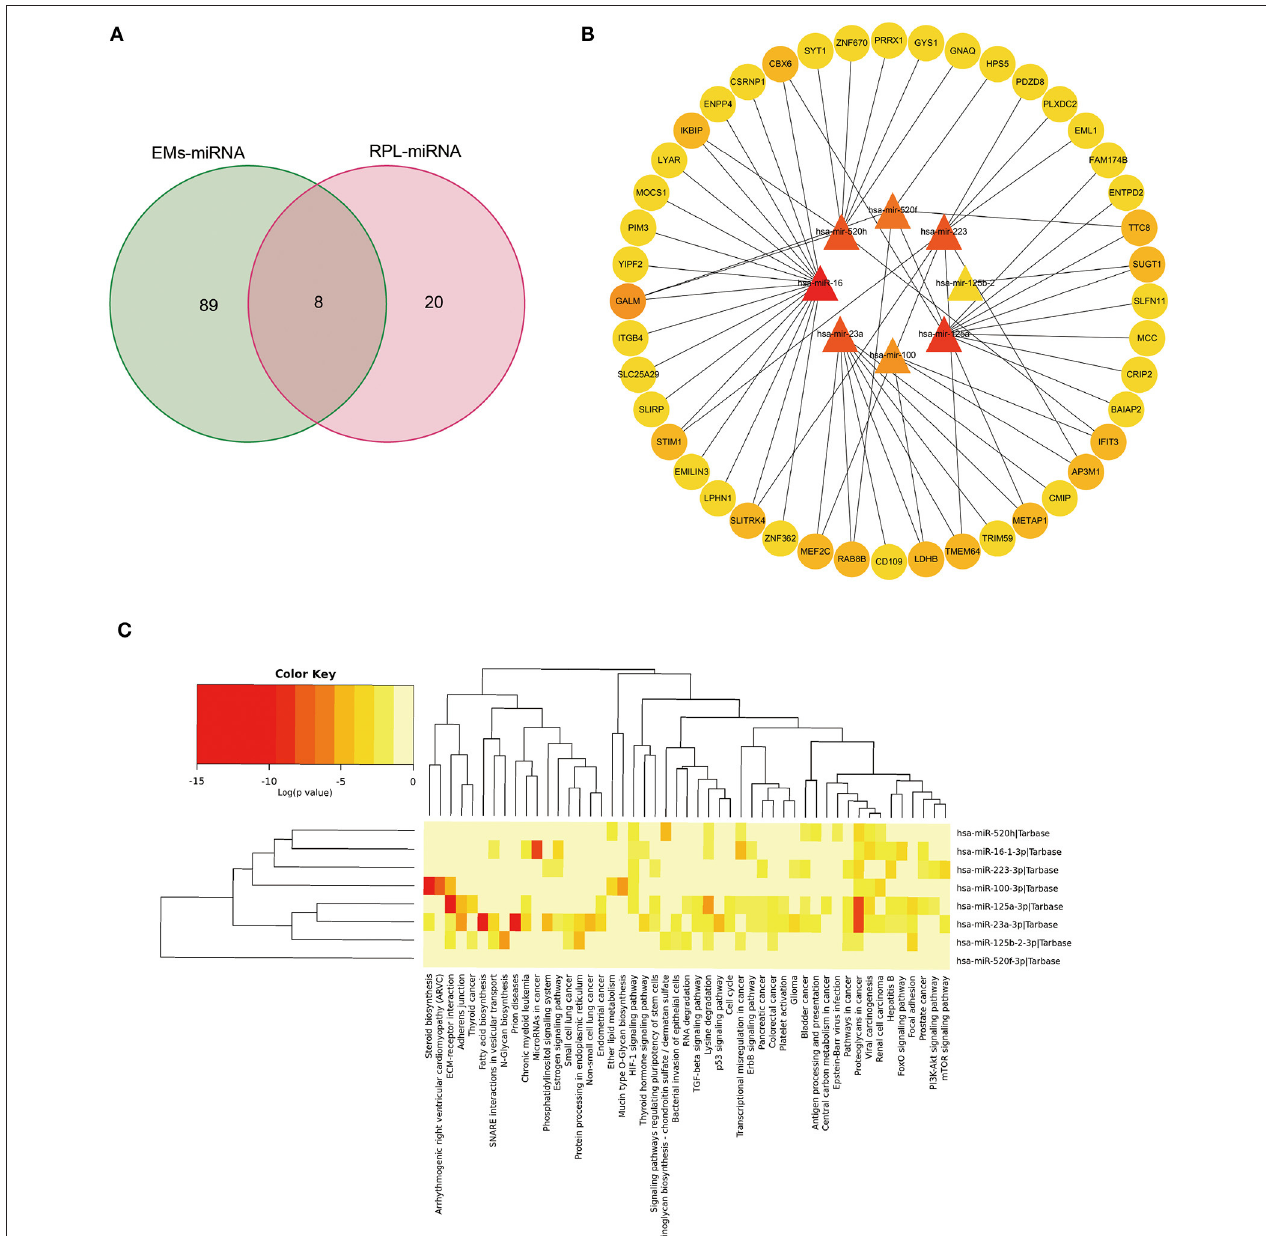
FIGURE 6 | Bioinformatics analysis of genes and miRNAs shared by EMs and RPL. (A) Venn diagram of the intersection of EMs-related and RPL-related miRNAs. (B) Regulatory network of shared miRNAs and corresponding shared genes for EMs and RPL. (C) KEGG pathway enrichment analysis of shared miRNAs of EMs and